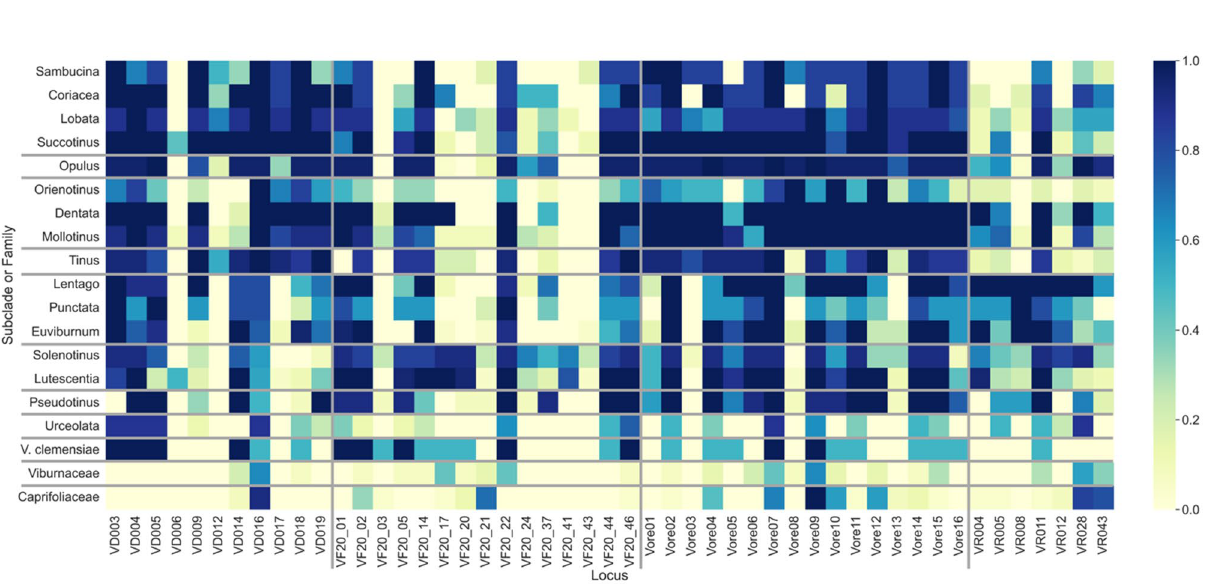
Figure 2. Heatmap of frequency of amplification per subclade or family for each of the 49 markers (loci). Vertical grey lines mark the separation of marker set groups and horizontal grey lines mark the separation of major clades and subclades/species not classified into major clades. The darker the square, the higher the amplification frequency of that marker for the sample